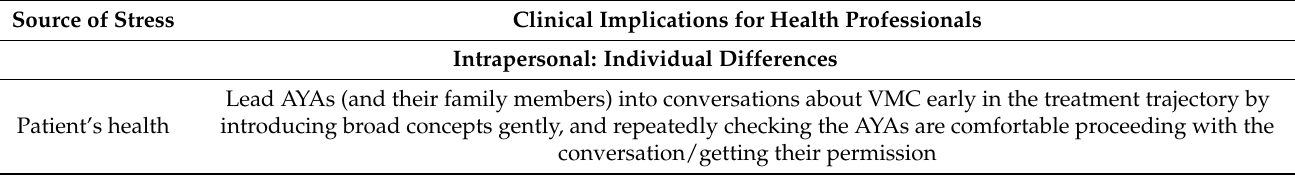
Table 5. Clinical practice implications for mitigating sources of stressfulness in Voicing My